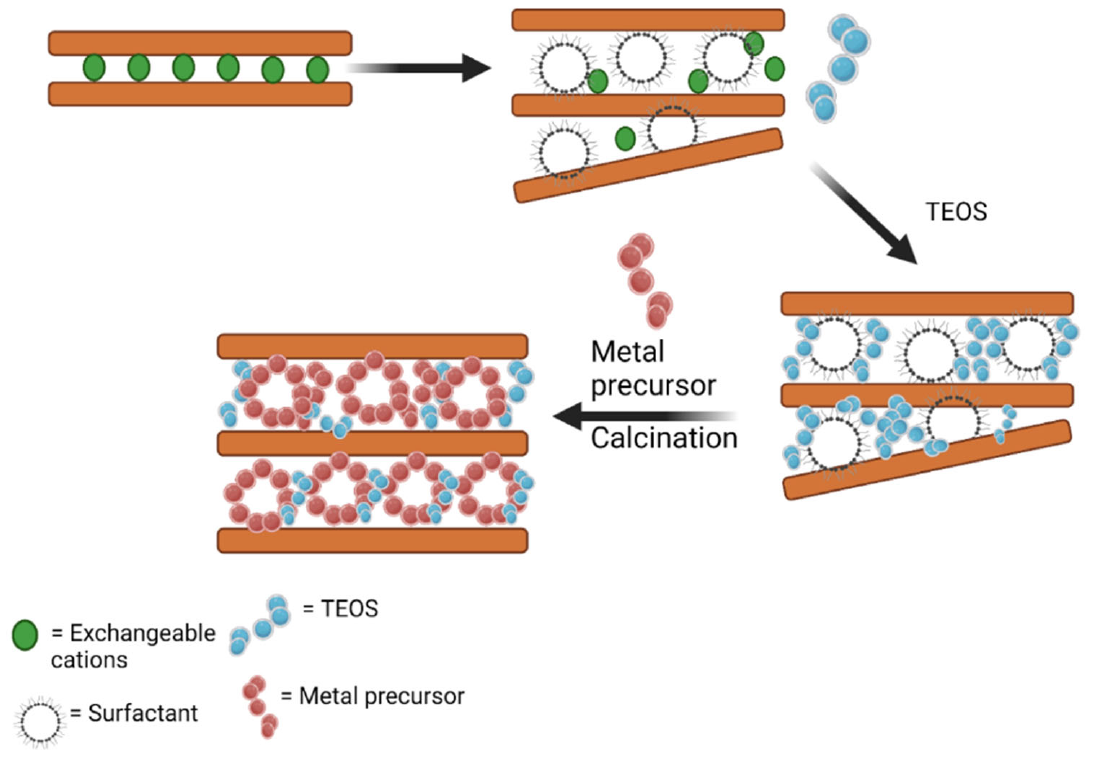
Figure 11. Schematic representation of porous clay heterostructure synthesis.